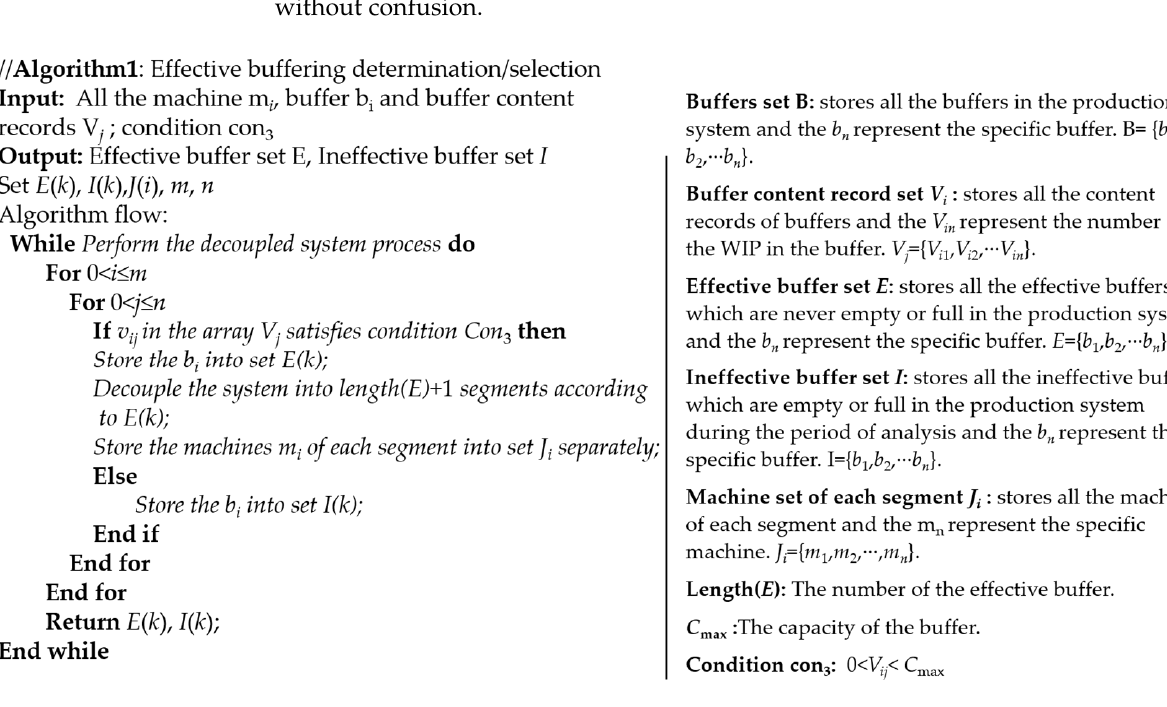
Figure 2. The effective buffering determination algorithm.